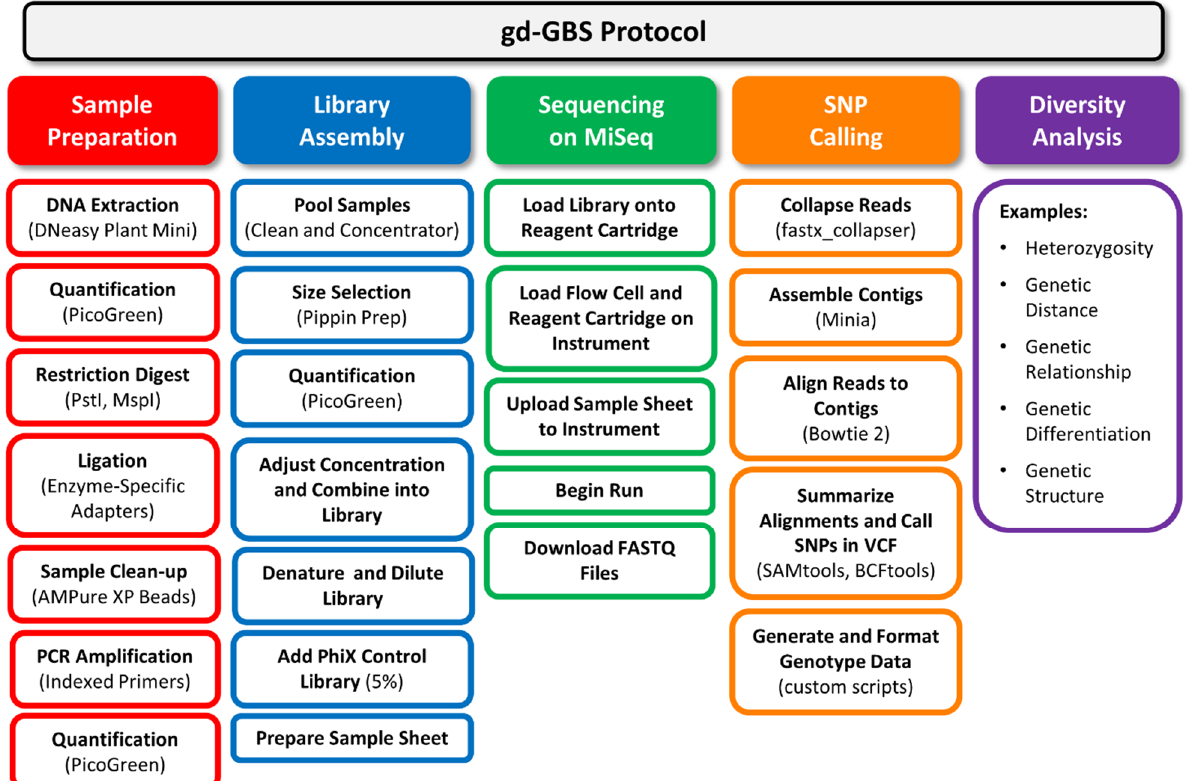
Figure 2. Flow chart of the genetic diversity-focused genotyping-by-sequencing (gd-GBS) protocol. The gd-GBS protocol consists of five major parts and many steps. Each part (filled box) relates back to the components in Figure 1. Arranged in columns beneath each part are the ordered major steps in outlined boxes of the same colour. Bracketed terms refer to specific equipment, reagents, kits or software